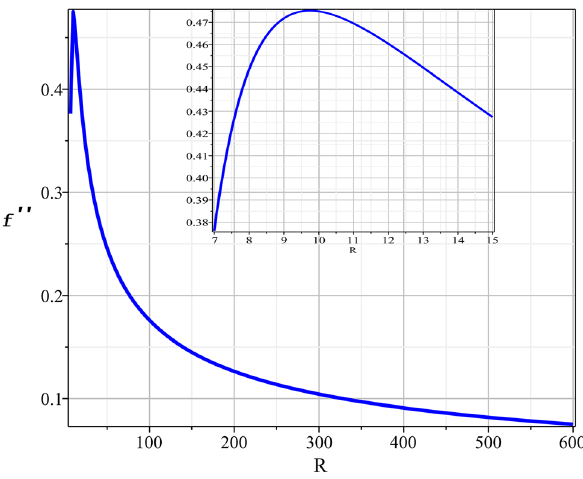
Fig. 5 This figure indicates the plot of f (cid:5)(cid:5) ( R ) (obtained from numeri- cal analysis) versus curvature R at curvature interval [ 7 , 600 ] . The input figure demonstrates the behavior of f (cid:5)(cid:5) ( R ) at low curvature interval [ 7 , 15 ] with a suitable